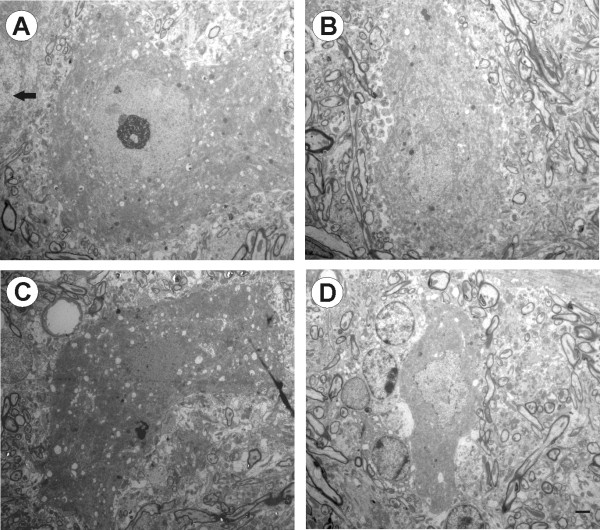
Electron photomicrographs showing degenerated neurons in IFNγ-KO mice. (A) One abnormal motoneuron amongst of normal cell (arrow). Cytoplasm and nuclei are electron dense; there are invaginations in the nuclear and cytoplasmic membranes and presence of many vacuoles in the cytoplasm. (B) The cell body appears shrunken and the nuclear envelope fragmented. (C) Darkly stained cytoplasm, condensed nuclear chromatin, and some organelles are hardly visible. (D) Glial cells are in close contact with a degenerating neuron. Note phagocytes of ingested material in the cytoplasm of microglial cells. Scale bar: 2 μm.